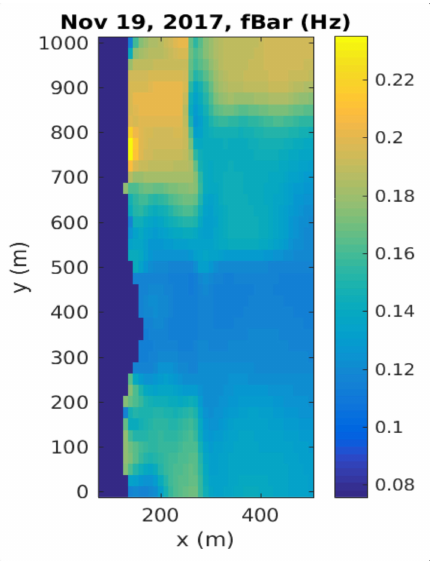
Figure 10. Map of fBar, the weighted mean frequency that contributed to phase 2 depth estimates in version 2.0.